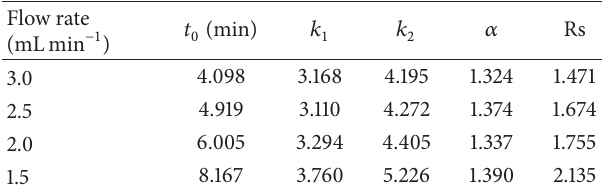
Table 2: Effect of flow rate on the stereoselective separation of TFLV a